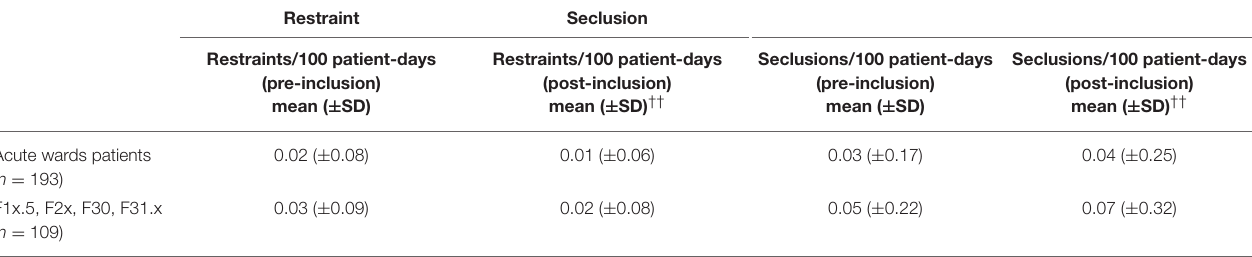
TABLE 7 | Number of seclusions and restraints before and after inclusion in the model project.